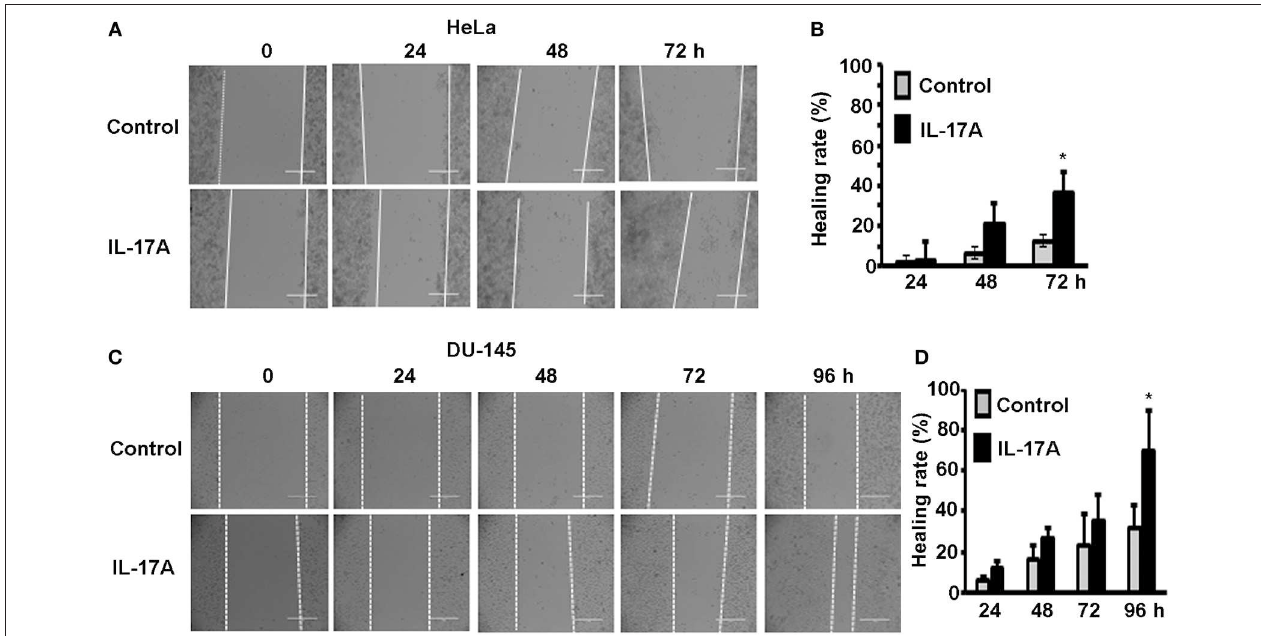
FIGURE 3 | IL-17A promotes migration of human cancer cells. Confluent monolayer of HeLa and DU-145 cells was scratched to make a wound and then treated without (control group) or with 20ng/ml recombinant human IL-17A for the indicated time points. (A,C) Representative photomicrographs of the wounds; dotted lines mark the front edges of migrating cells; scale bar, 400 µ m. (B,D) Wound healing rate was calculated as (wound width of time zero–that of each time point) ÷ wound width of time zero × 100%; data represent mean ± standard deviation (SD, error bars) of 3 independent experiments; * p < 0.05 between the IL-17A-treated group and the untreated control